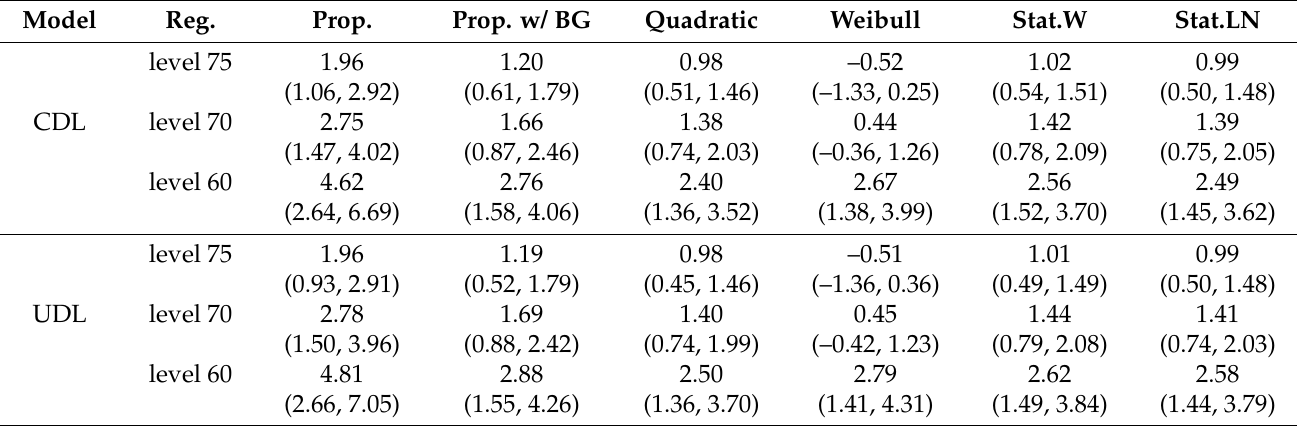
Table 2. Posterior means and 95% confidence intervals of total mortality reduction per 1000 deaths (1998–2000): city-specific rollback.